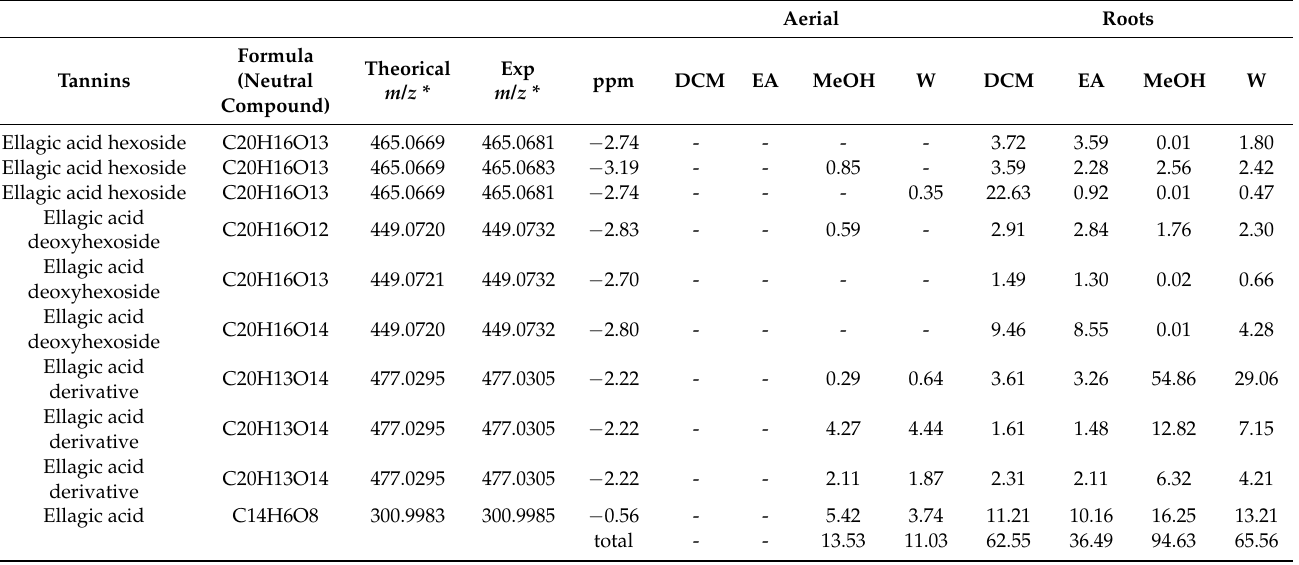
Table 4. Content of tannins identified and quantified in the extracts, expressed as mg/g on dry extract. MS data were acquired in negative ion mode (ESI( −